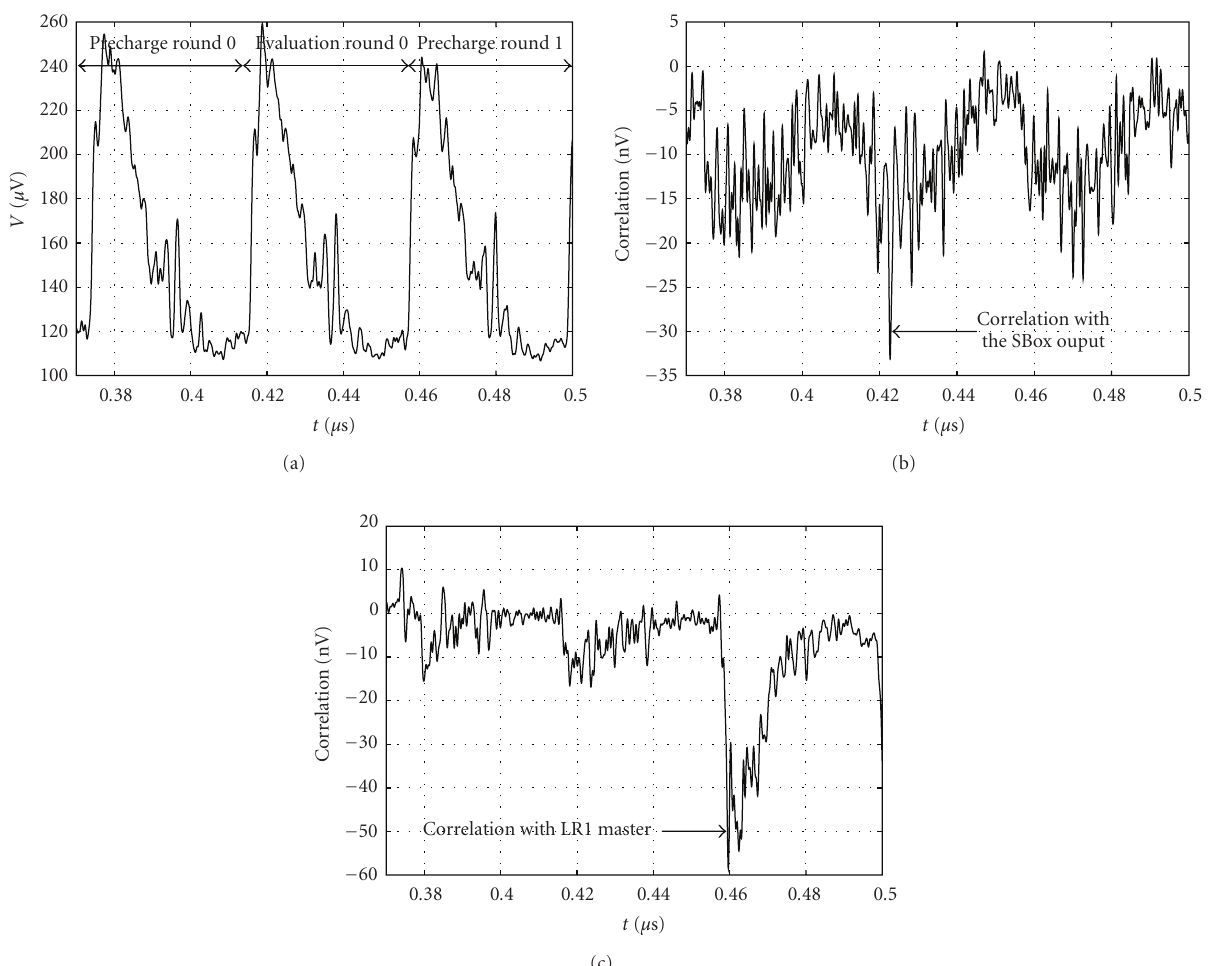
Figure 13: From (a)–(c) single trace and di ff erential traces when targeting the SBox1 and the LR registers.